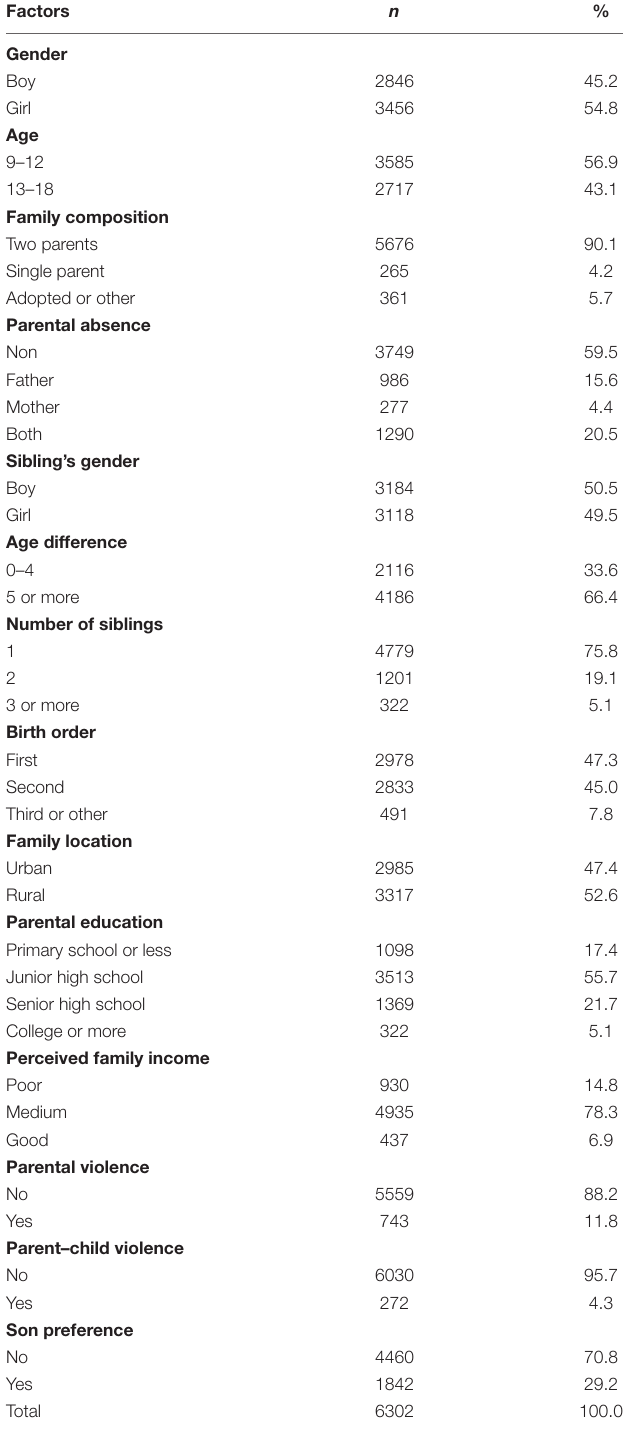
TABLE 1 | The characteristics of the